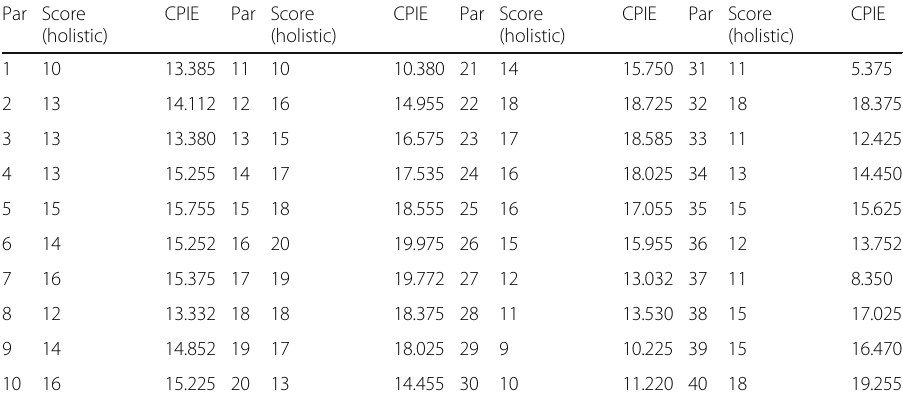
Table 5 CPIE recalculation of scores (Par, participant) Par Score (holistic)